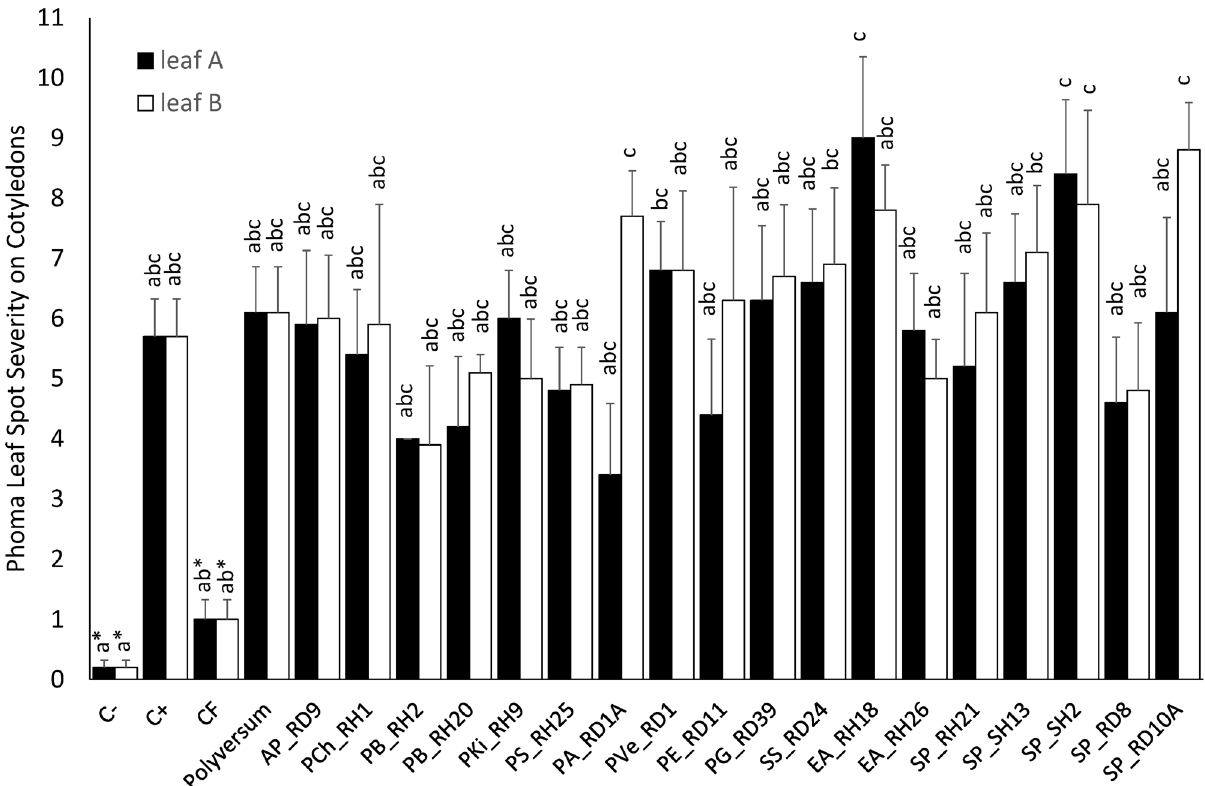
Figure 5. Effect of selected bacterial endophytes on Phoma disease ( Leptosphaeria maculans, anamorph Phoma lingam ) in a cotyledon assay on oilseed rape seedlings. Data are presented as means ± SE; AP = Achromobacter piechaudii , PS = Pseudomonas sp . , EA = Enterobacter amnigenus , SP = Serratia proteamaculans, SS = Stenotrophomonas sp., C = negative (healthy) control without Phoma inoculation and without